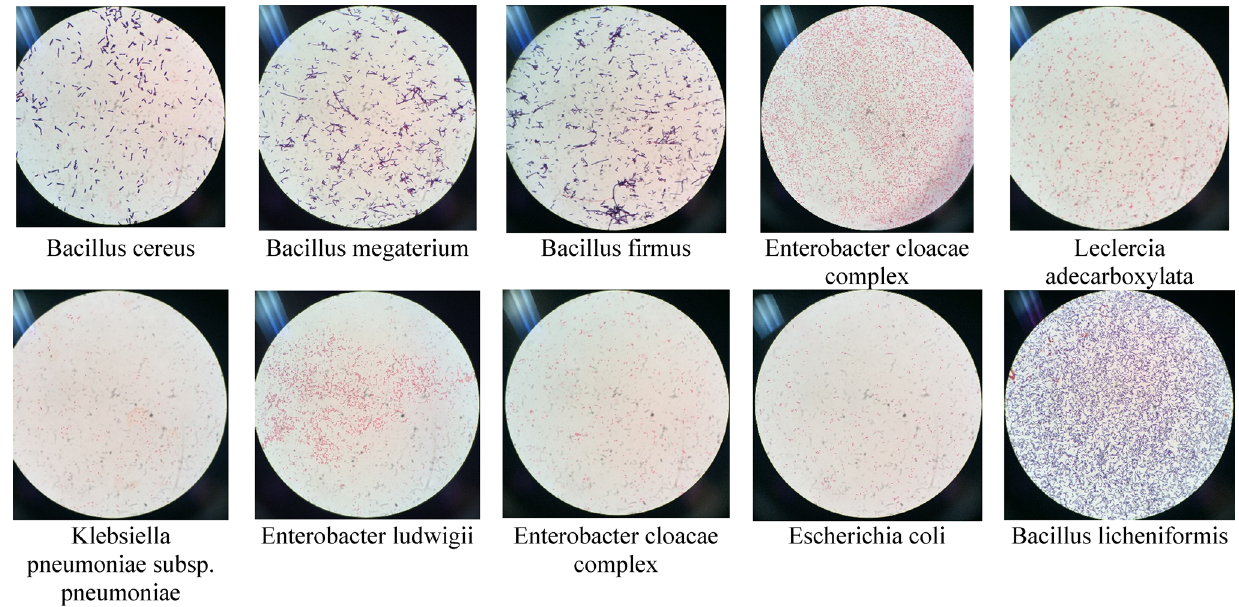
Fig. 5 Selected gram-stained bacteria obtained from bio-coal briquettes product treated by Garant